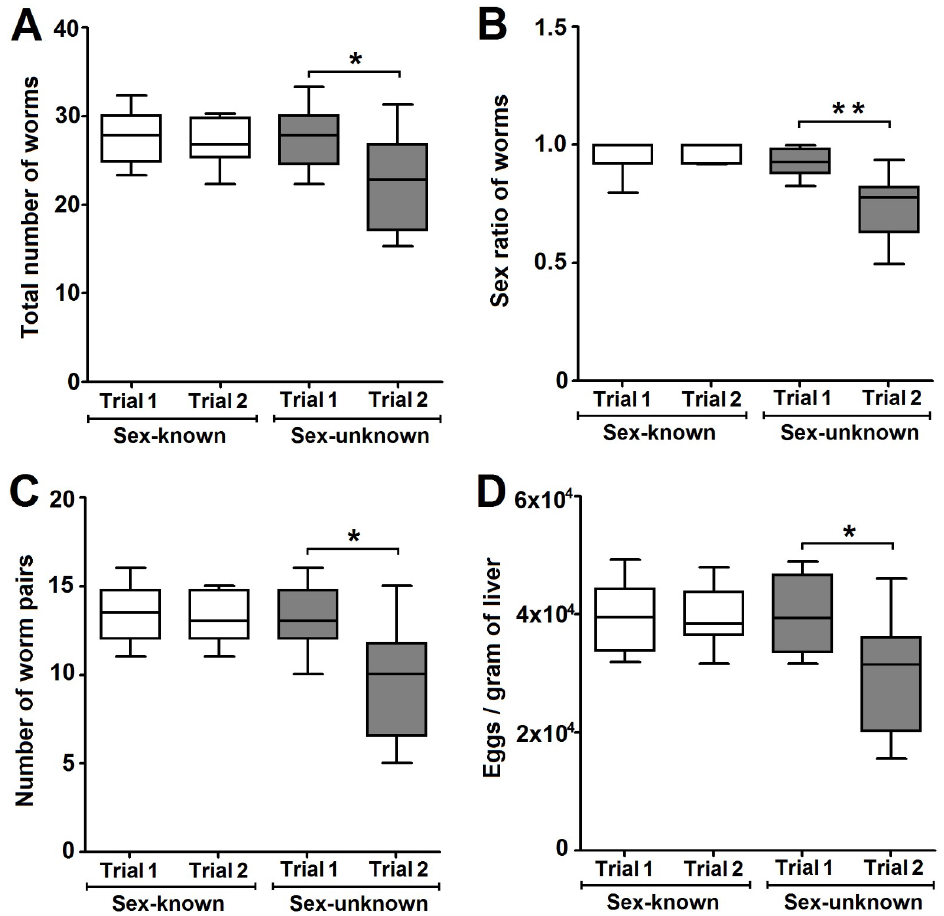
Fig 6. Reliable schistosomiasis mouse models using sex-known cercariae infection. Worm burdens (A) , sex ratio of worms (B) , worm pair burdens (C) , and egg burdens (D) of schistosomiasis mouse models from two independent trials. Horizontal lines represent the median values, and boxes and whiskers represent the inter-quartile and min-max ranges (n = 8), respectively. � represents P < 0.05, and �� represents P < 0.01.